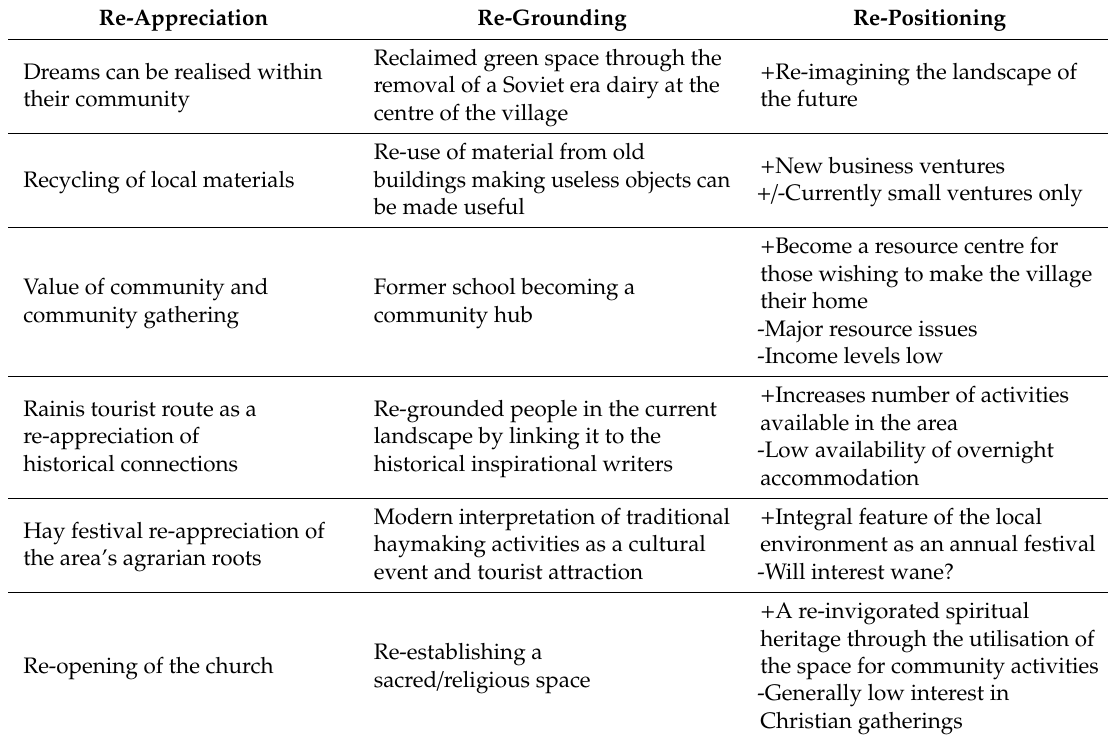
Table 4. The most important aspects of place-shaping in Kaldabrun